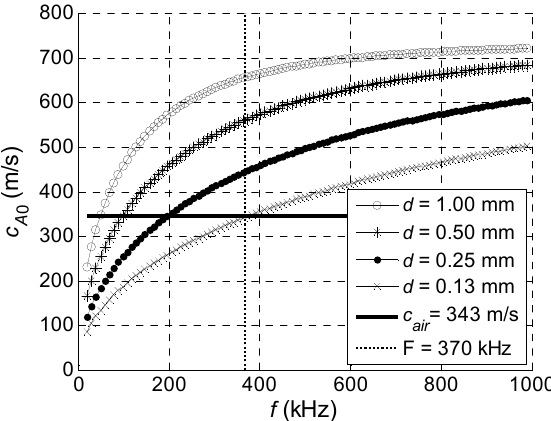
Figure 4. Calculated phase velocities c A 0 of the A 0 Lamb wave mode in PVC films of different thickness d .